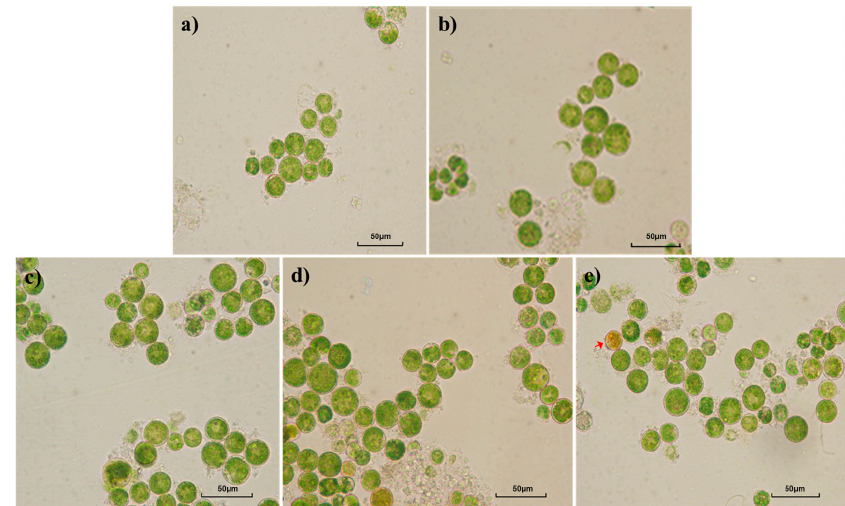
Figure 4. Cell morphology of H. pluvialis under different values of low light intensities of 20 ( a ), 40 ( b ), 60 ( c ), 80 ( d ), and 100 ( e ) µmol photons m − 2 ·s − 1 (red arrow indicates a red palmella cell with accumulated astaxanthin).